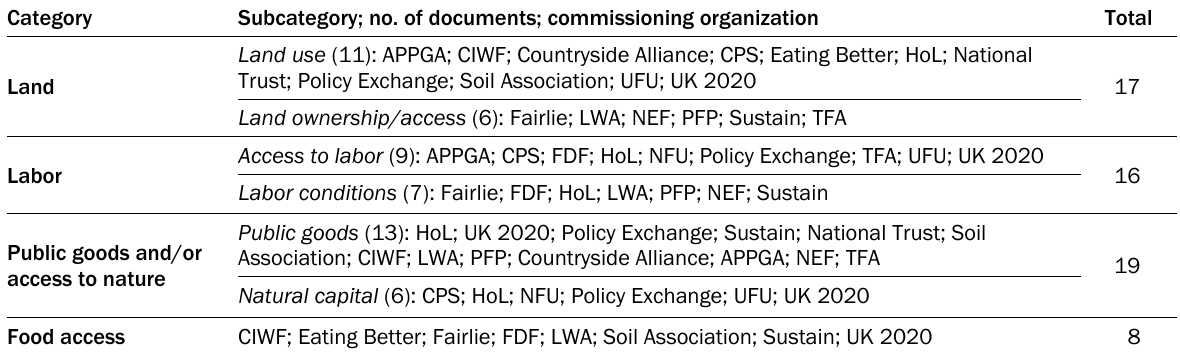
Table 2. Summary of Documents in Terms of the Various Categories of “Distributive